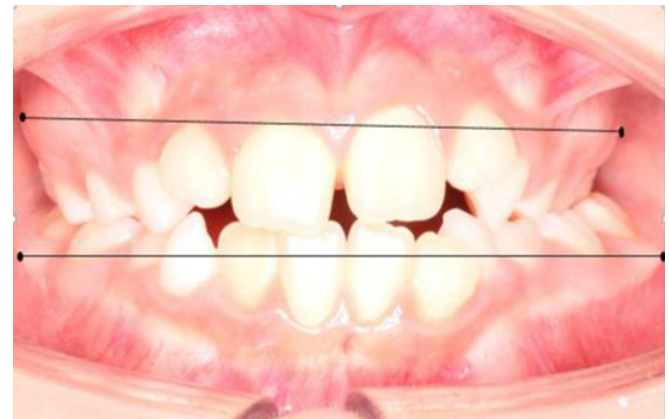
Figure 3. Measurement of maxillary and mandibular width from the location of the Wala Ridge points at the level of the first permanent molar. Figure obtained by Dr. Ramon Herrero R.